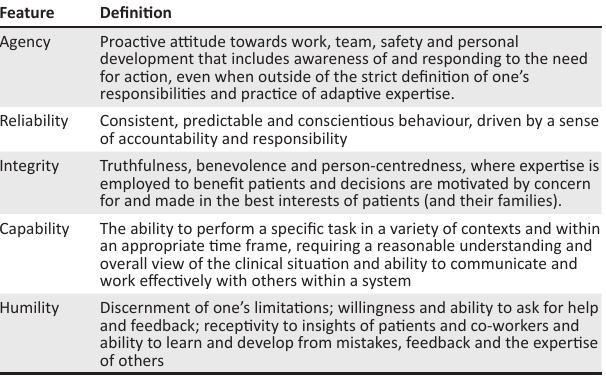
TABLE 2: Professional behaviour that enables